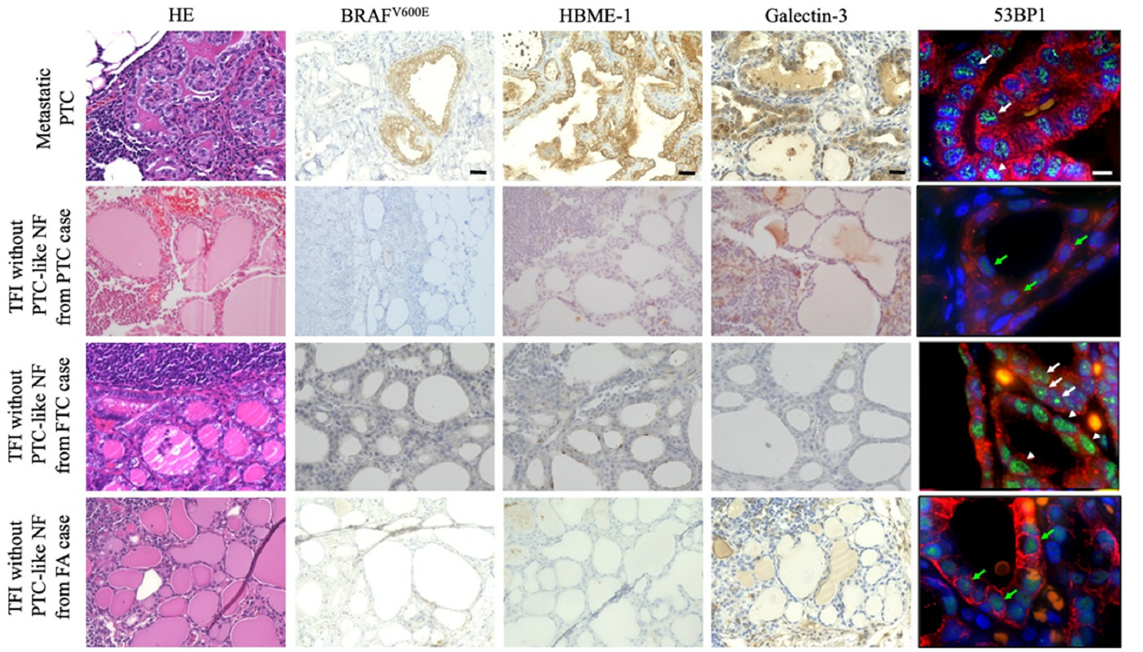
Figure 1. Immunohistochemistry (IHC) of biomarkers for papillary thyroid carcinoma (PTC), such as BRAF V600E , Hector Battifora mesothelial epitope (HBME)-1, and galectin-3 expression, and double immunofluorescence (IF) for p53-binding protein 1 (53BP1) (green) and pan-cytokeratin (AE1/AE3) (red) expression to detect follicular epithelium in primary thyroid tumors. In IF, the arrowheads and white and green arrows indicate the diffuse, DDR, and stable types of 53BP1 expression, respectively. The scale bars represent 30 µm and 10 µm in HE/IHC and IF, respectively.